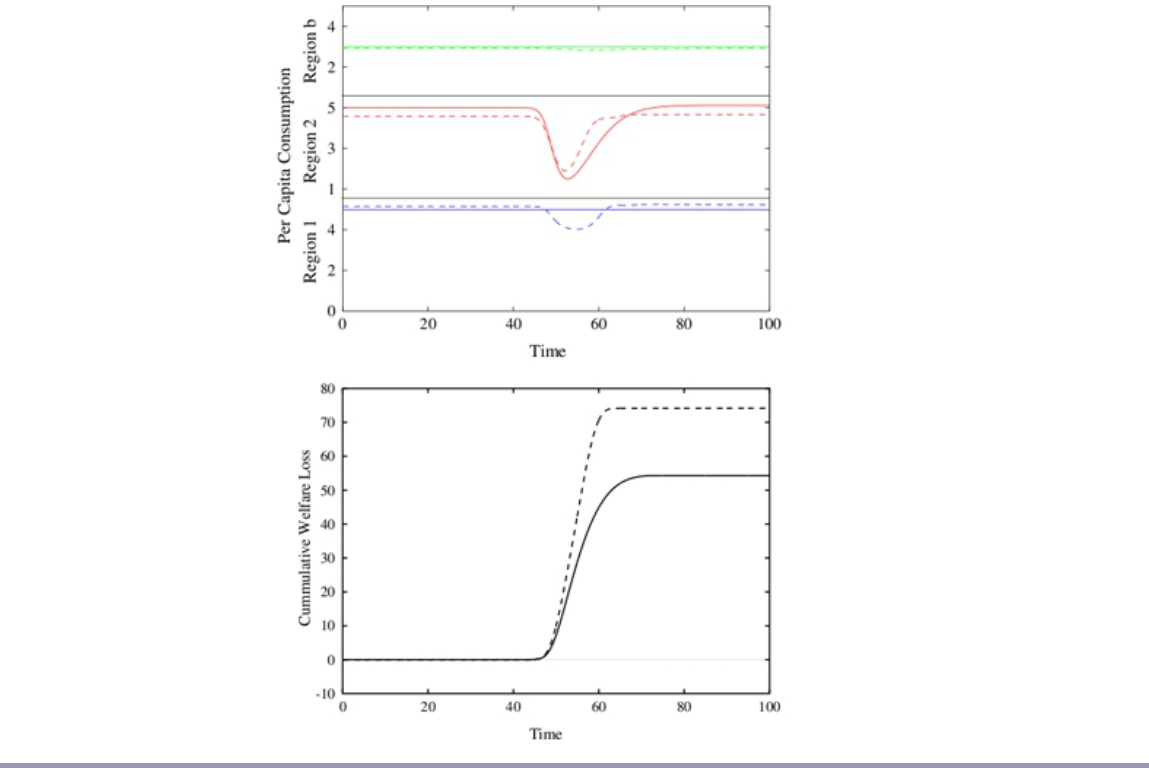
Fig. 7 . Per capita consumption (top) and cumulative welfare loss (bottom) as a function of time after a high-frequency weather variation (shock) that reduces resource densities in Region 2. Solid lines show the case without migration, dashed with migration. Note that there may be multiple scales on the